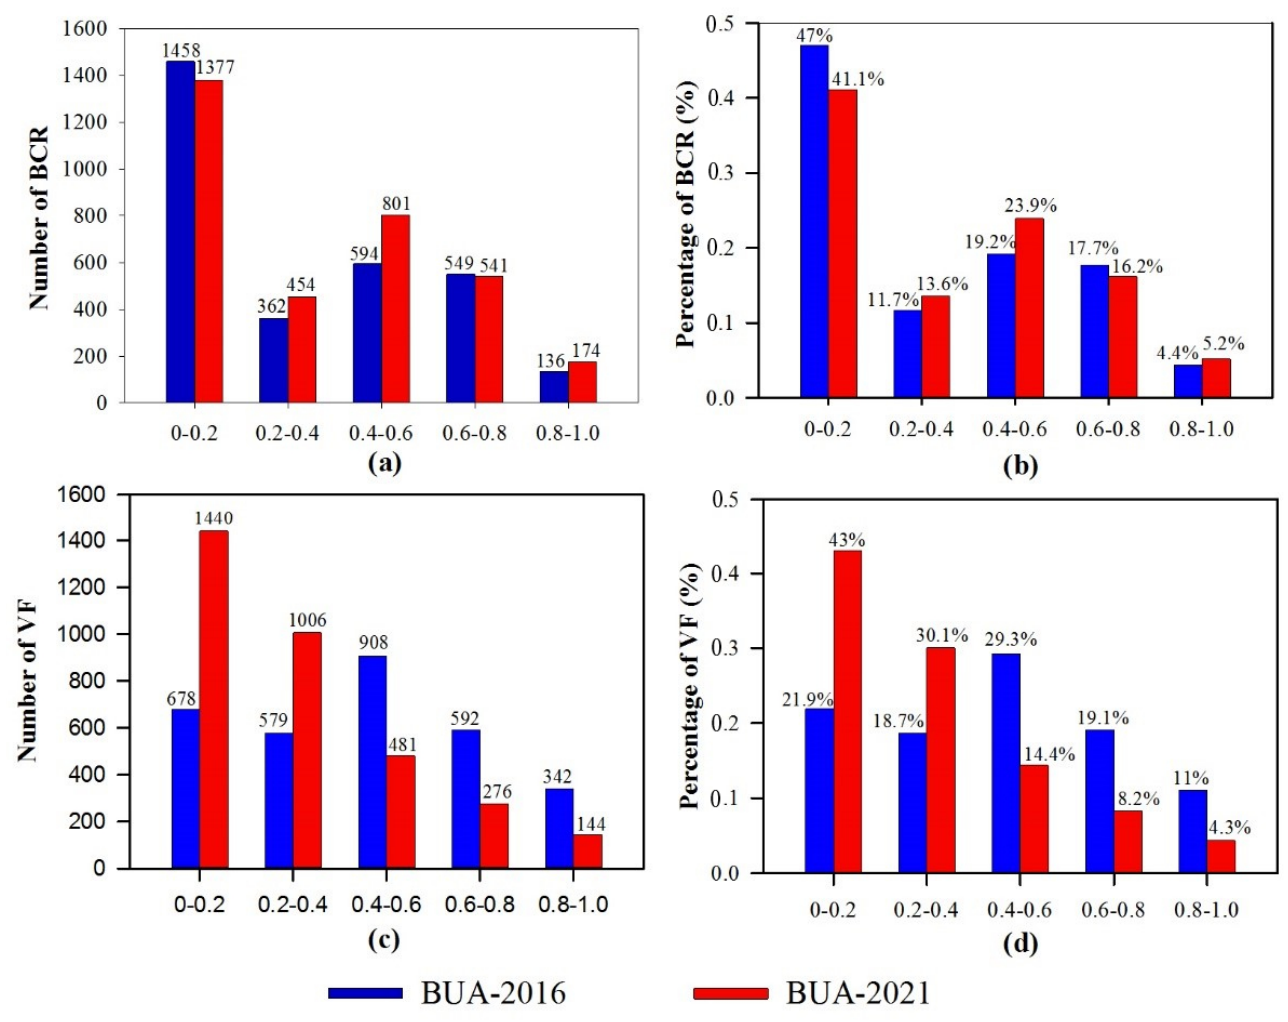
Figure 11. Statistical analysis of the building coverage ratio (BCR) and vegetation fraction (VF) within the city-block scale of urban built-up areas: ( a , b ) indicate the number and proportion of the BCR within the statistical interval, respectively; ( c , d ) indicate the number and proportion of the VF within the statistical interval, respectively.